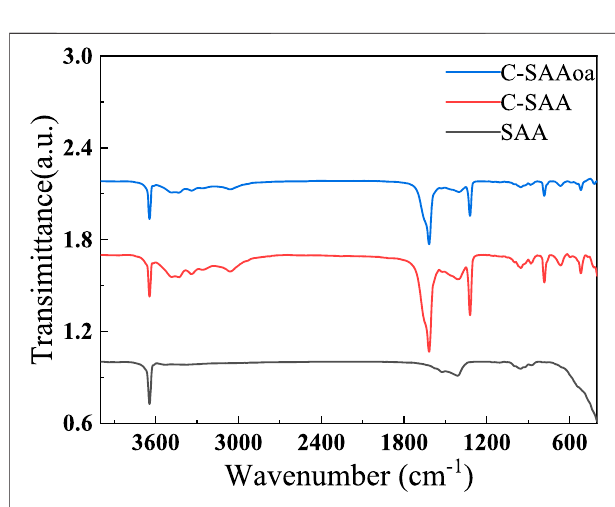
FIGURE 5 | The FTIR spectra of SAA 、 C-SAA and C-SAA oa